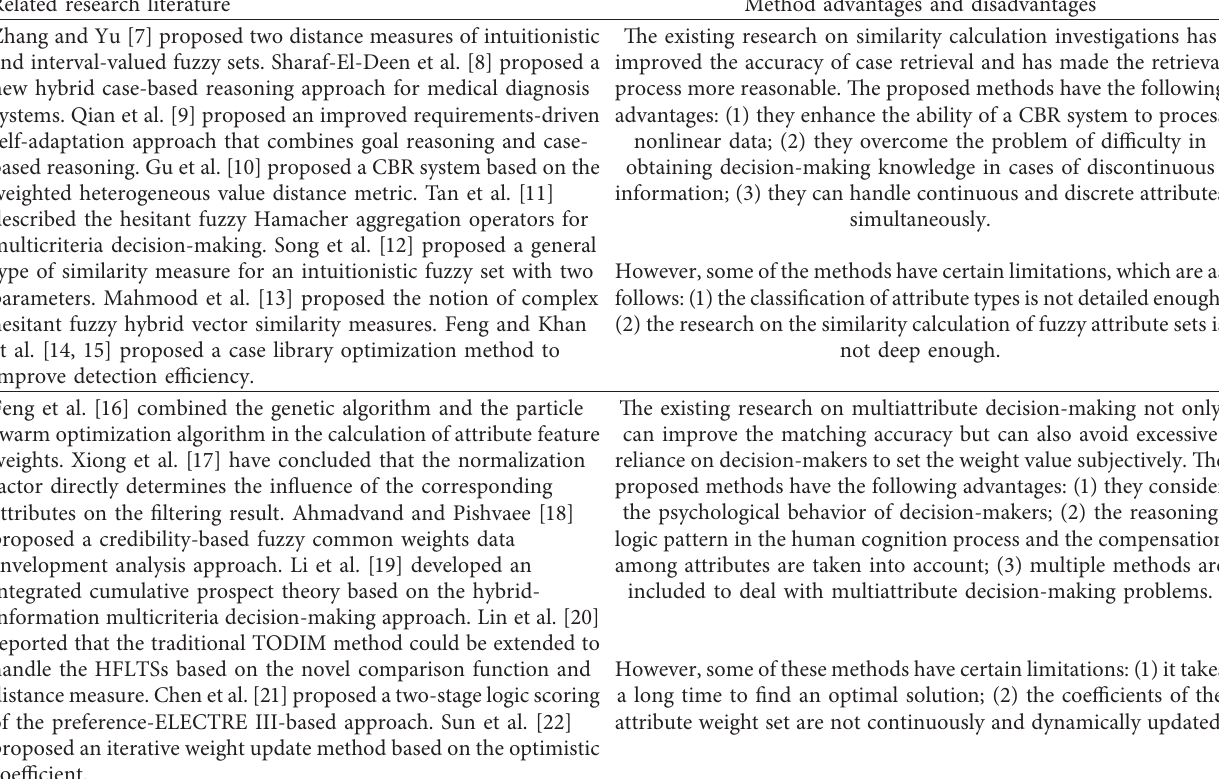
Table 1: Related research